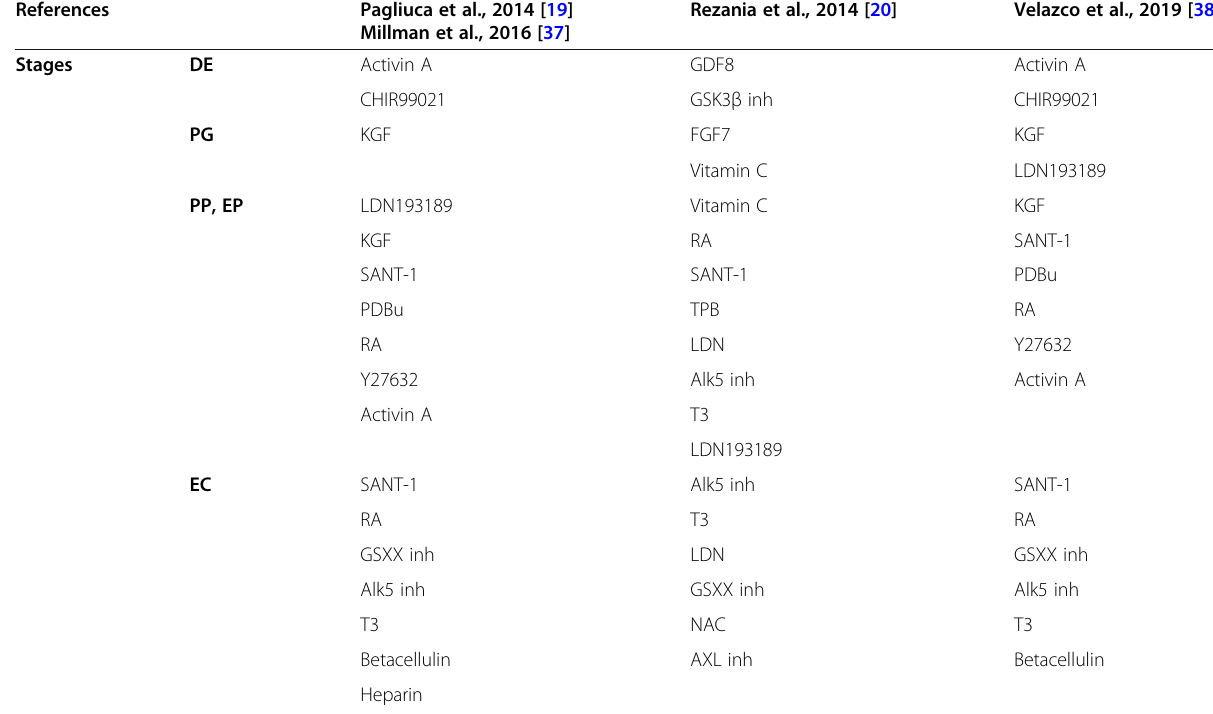
Table 2 A list of growth factors or chemicals used for generating functional PSC-derived